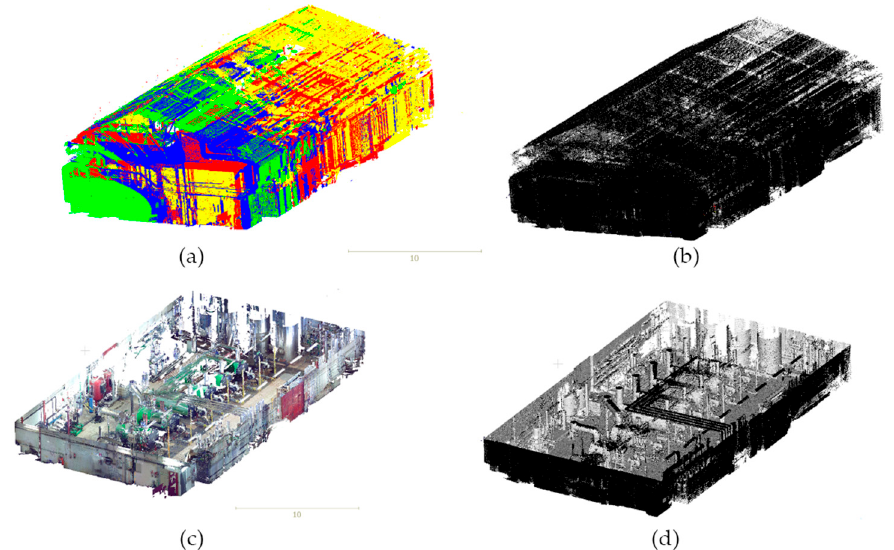
SD (m) Sphere Zeb-Revo Faro